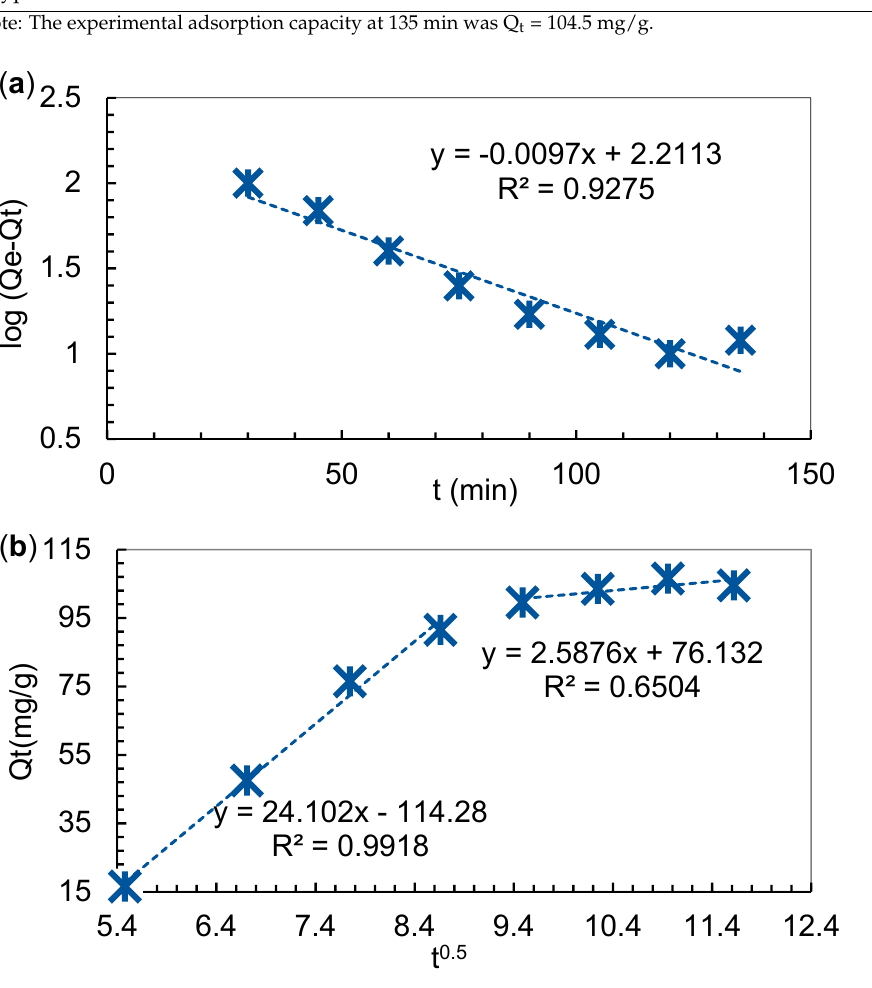
Figure 2. Experimental kinetic data fit of: ( a ) PFO and ( b ) Weber–Morris. The intra-particle diffusion model proposed by Weber and Morris may be expressed with the following Equation: where C is the quantity of AB 113 adsorbed at the surface of the IRA 402 resin mass and K id (mg/g min 0.5 ) represents the intraparticle diffusion rate constant. From the slope